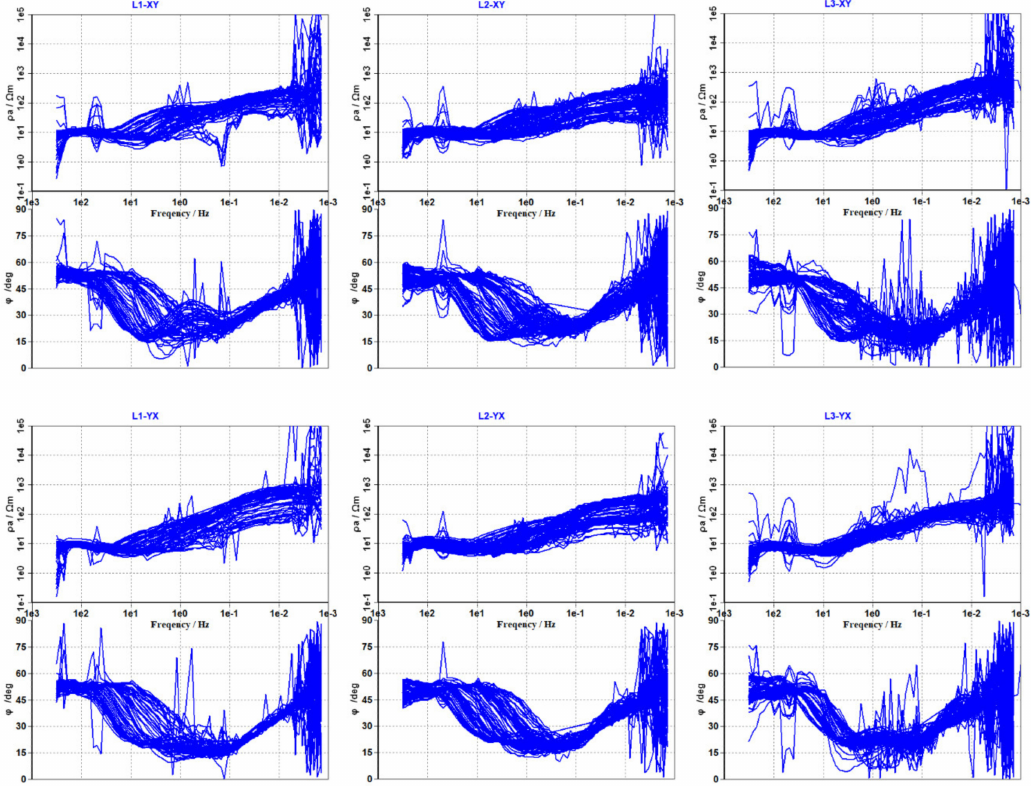
Figure 6. Superimposed display of the observed apparent resistivity and impedance phase curves in the geographic coordinate system. The top part presents apparent resistivity, and the bottom part presents the impedance phase. ( left ) L1 line, ( middle ) L2 line, and ( right ) L3